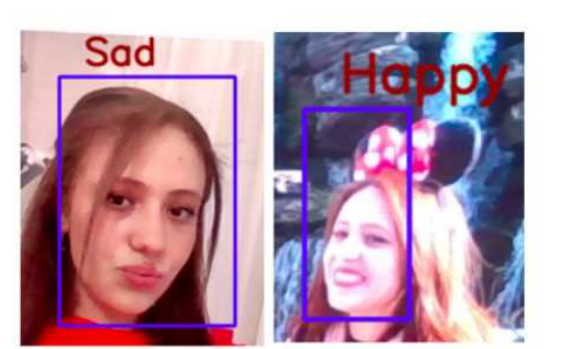
Figure 8 . Sample of real time predictions (Author’s Original Picture)